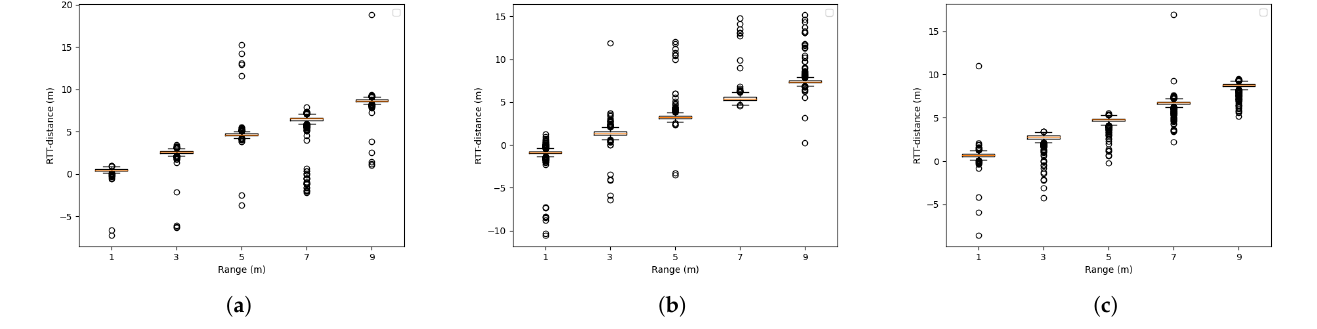
Figure 10. Raw Wi-Fi RTT distance measured by the three smartphones in RFPV and LOS condition: ( a ) Google Pixel 2; ( b ) Xiaomi Redmi K20; ( c ) LG V50S.